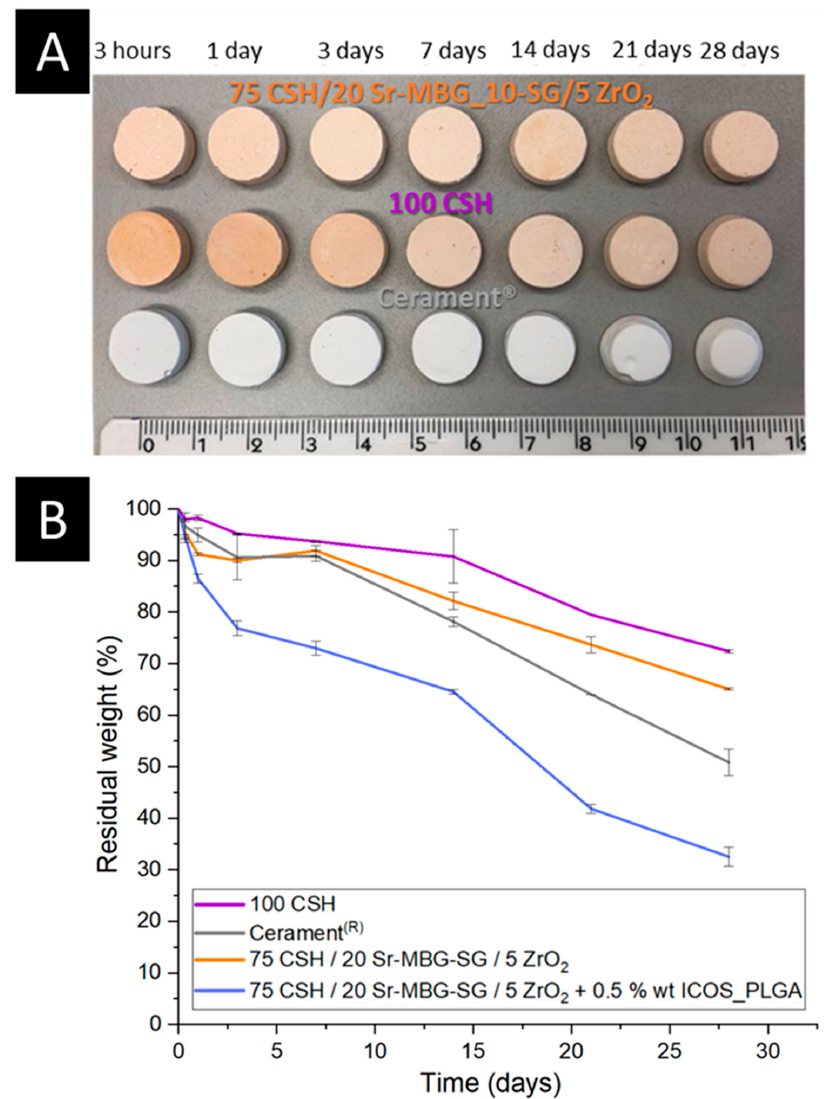
Figure 5. Degradation kinetics of tested samples that degrade by bioerosion process ( A ) and weight loss of samples once immersed in Tris-HCl up to 28 days ( B ).